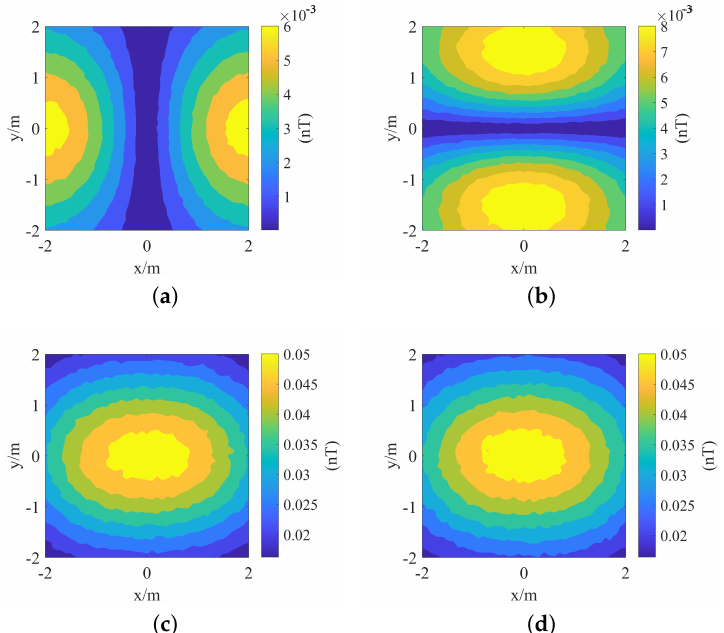
Figure 7. The secondary field strength map of a cylindrical target ( θ = 90 ◦ ). ( a ) the component B x of the secondary field in the x -axis direction; ( b ) the component B y of the secondary field in the y -axis direction; ( c ) the component B z of the secondary field in the z -axis direction; ( d ) total secondary field B s .